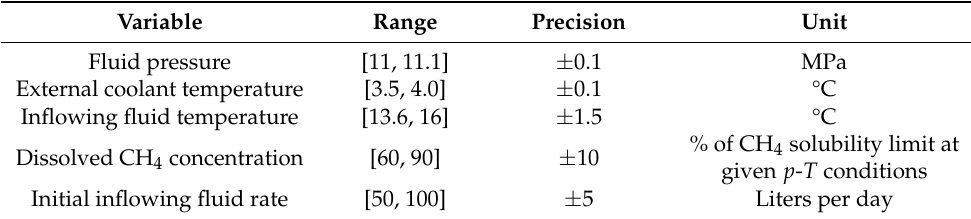
Table 4. Main variables for determining thermo-physically reasonable initial and boundary conditions for model calibration.